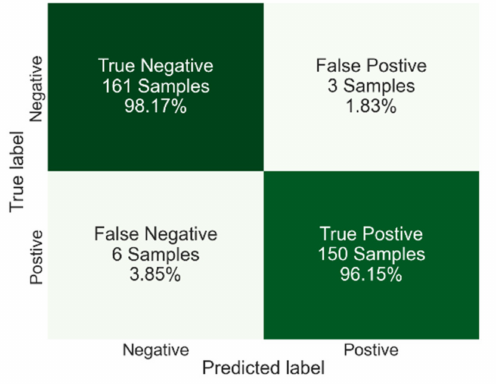
Figure 11. Confusion matrix results for the CNN algorithm with an overall accuracy of 97.20%, specificity of 98.17%, and sensitivity of 96.15%.